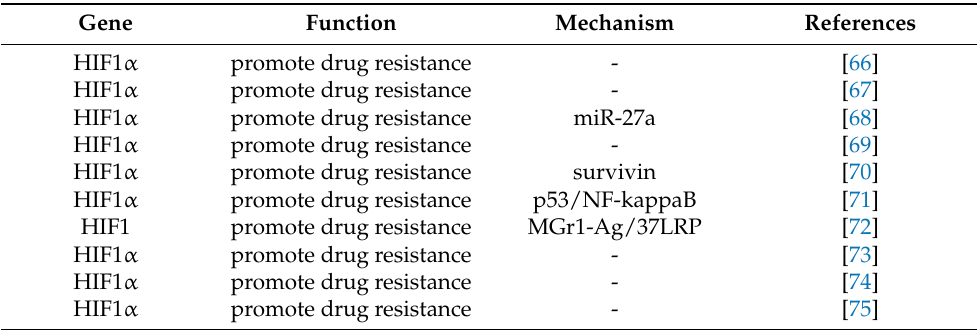
Table 4. HIF regulates gastric cancer progression by gastric cancer cell drug